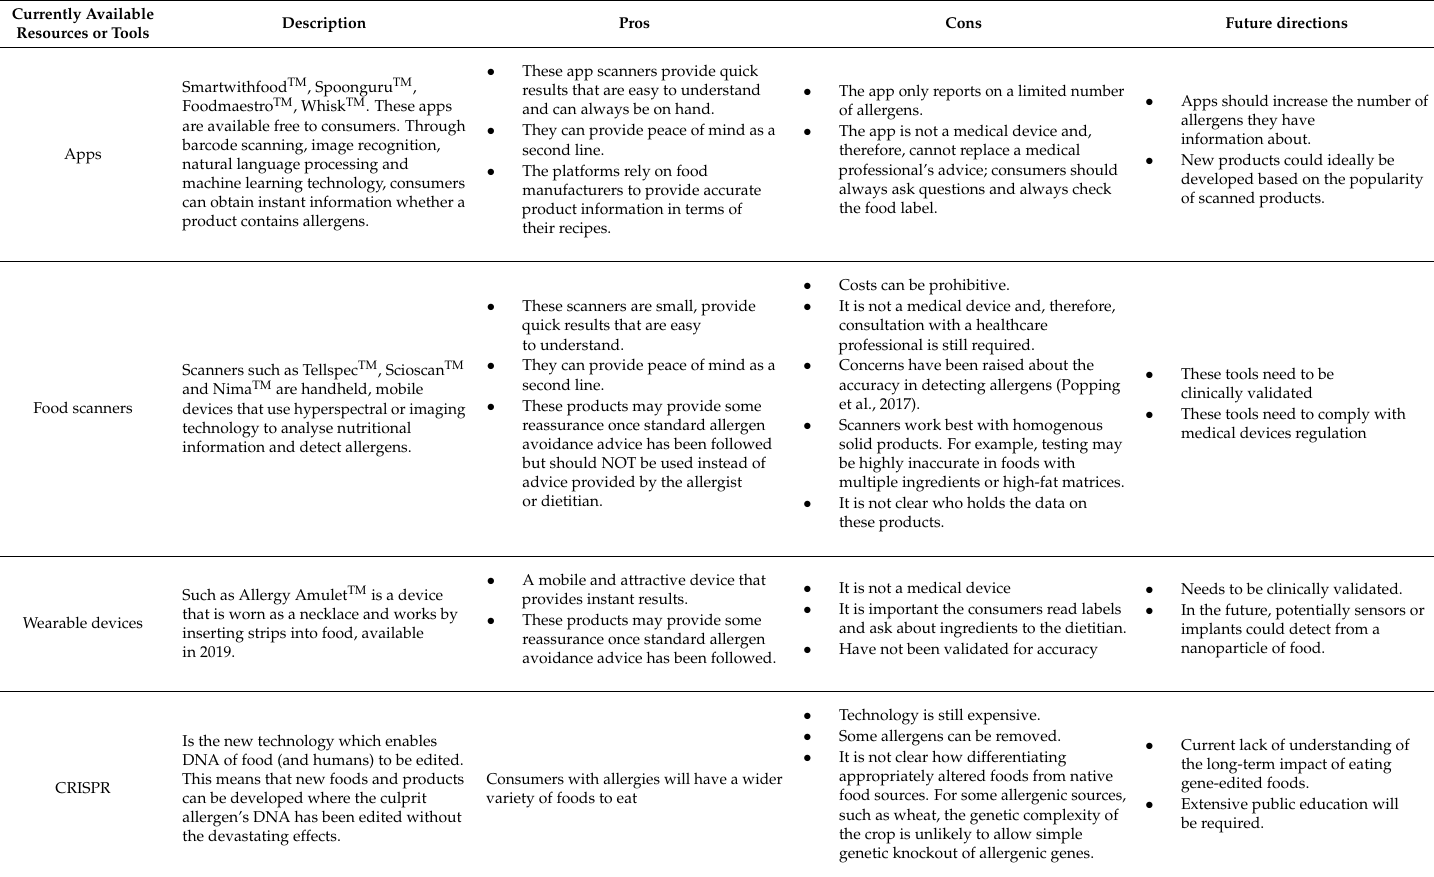
Table 3. Personalized nutrition offering for Food